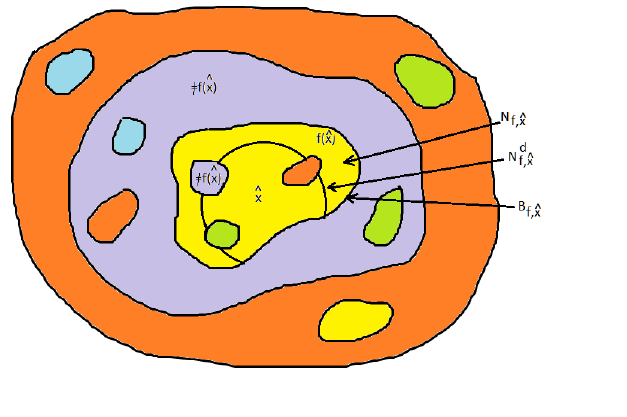
Figure 1. A counterfactual space around ˆ x